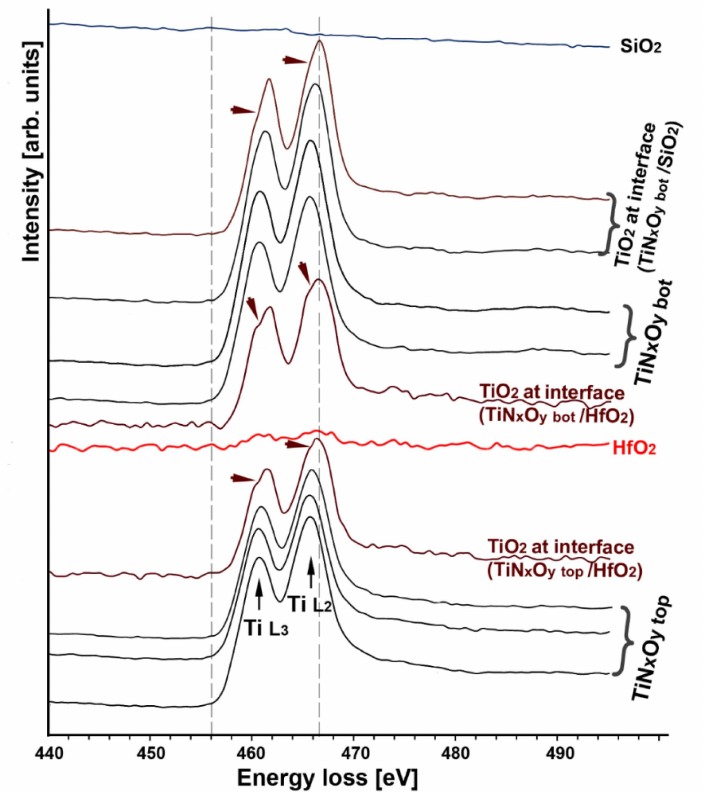
Figure 7. Shape evolution of the Ti-L 2,3 edges across the SiO 2 —TiN x O y bottom—La:HfO 2 —TiN x O y top interfaces in the interfacial regions where a splitting in the Ti-L 2 and Ti-L 3 peaks (indicated by arrows) shows that TiO 2 appears at the interface and chemical shift towards higher energy of the Ti L 2,3 edges from titanium oxide (spectra are shifted vertically for more